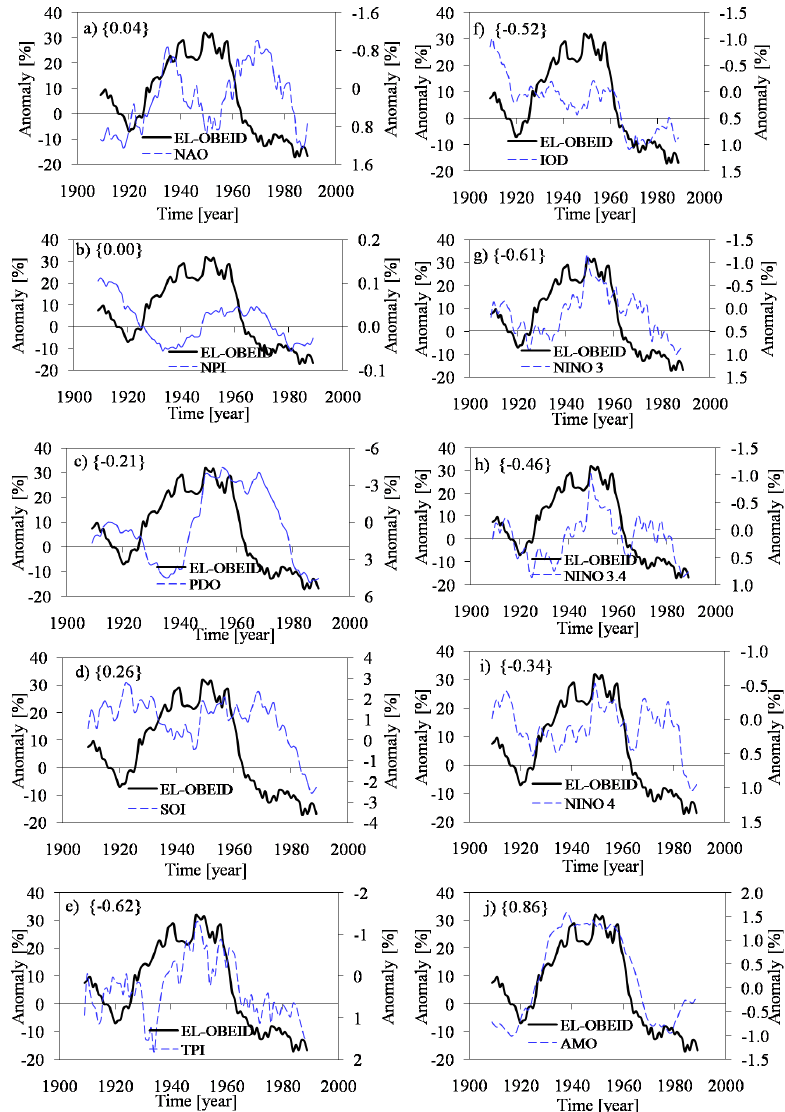
Figure 8. QPM results for annual rainfall and climate indices; the correlation coefficient between the two curves of each chart is labeled in { }